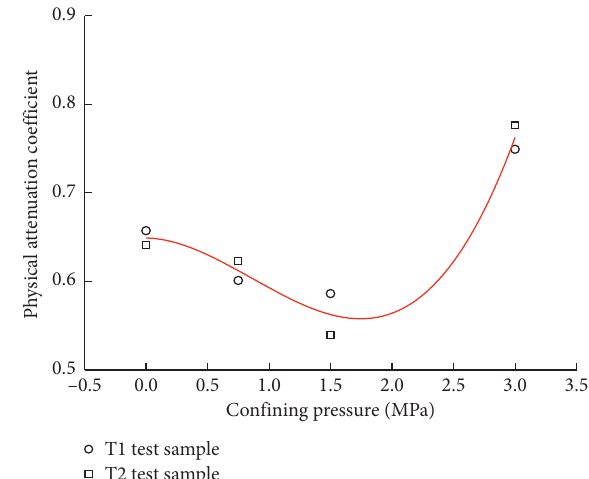
Figure 20: Variation law of physical attenuation coefficient under different confining